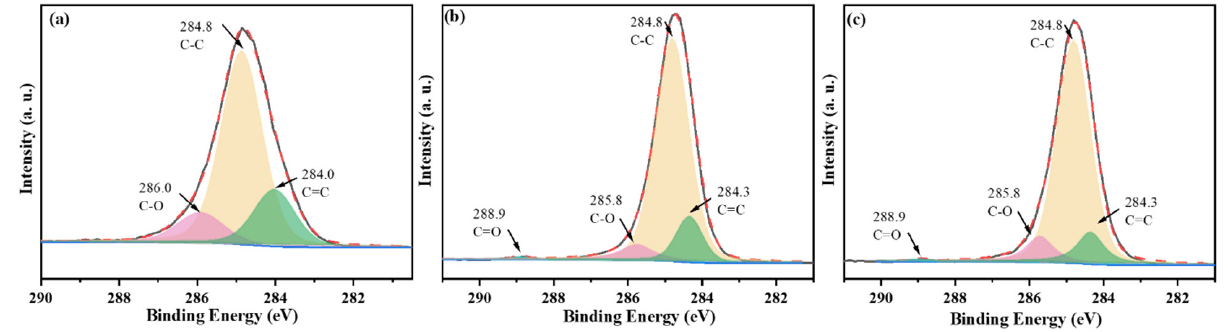
Figure 11. High-resolution C 1s spectra in CSPAC ( a ) before and ( b ) after the reaction in the Fe 3+ /CSPAC/H 2 O 2 system, and ( c ) after the reaction in the Fe 3+ /CSPAC system.